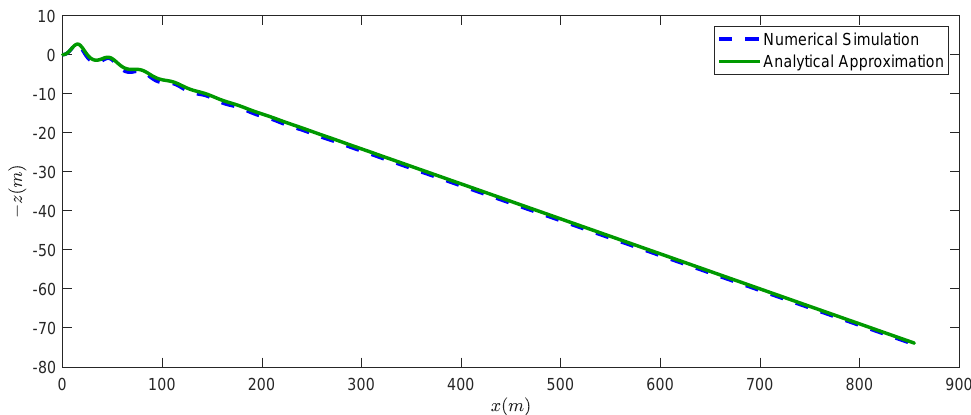
Figure 8. Comparison between the trajectories at 5